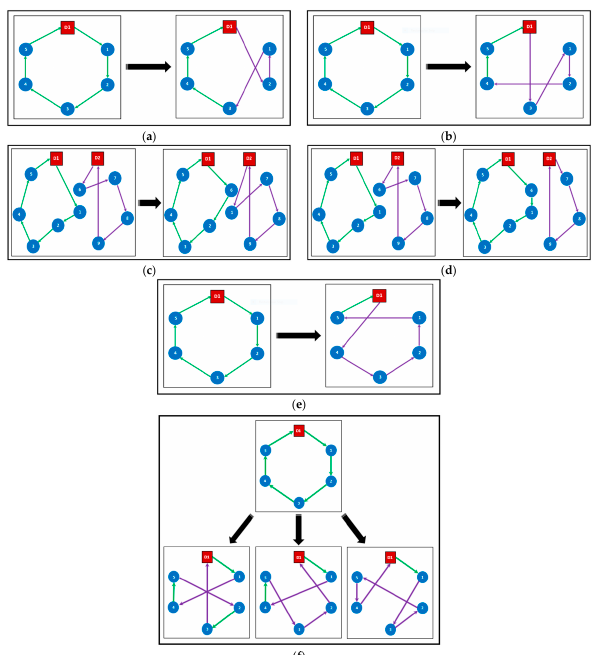
Figure 2. The figures show how each of the multi-neighbourhood search techniques finds their neighborhood: ( a ) Swap within depot: customer 1 and 2 are swapped within the same depot; ( b ) Insertion: customer 3 are inserted in between depot and customer 1 in the route sequence; ( c ) Swap between depots: customer 6 in depot 1 is swapped with customer 1 in depot 2; ( d ) Relocation: customer 6 in depot 2 is moved to depot 1; ( e ) 2–Opt: swap customer 1 and 4 in the same route and the route sequence between swapped customers are reversed; ( f ) 3-Opt: three possibilities of 3-Opt which are either non-reversing, one reversing or two reversing